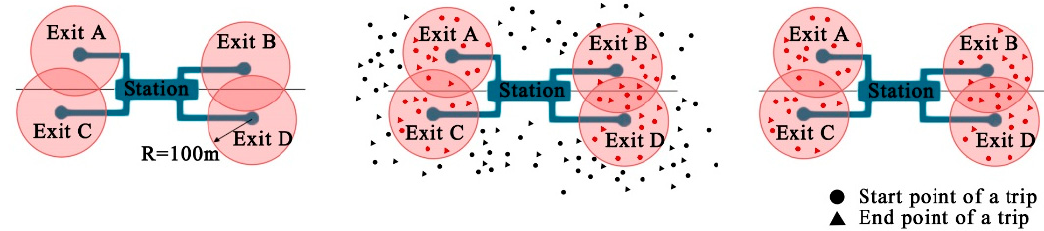
Figure 2. Process of identifying bicycle-metro integration trips.